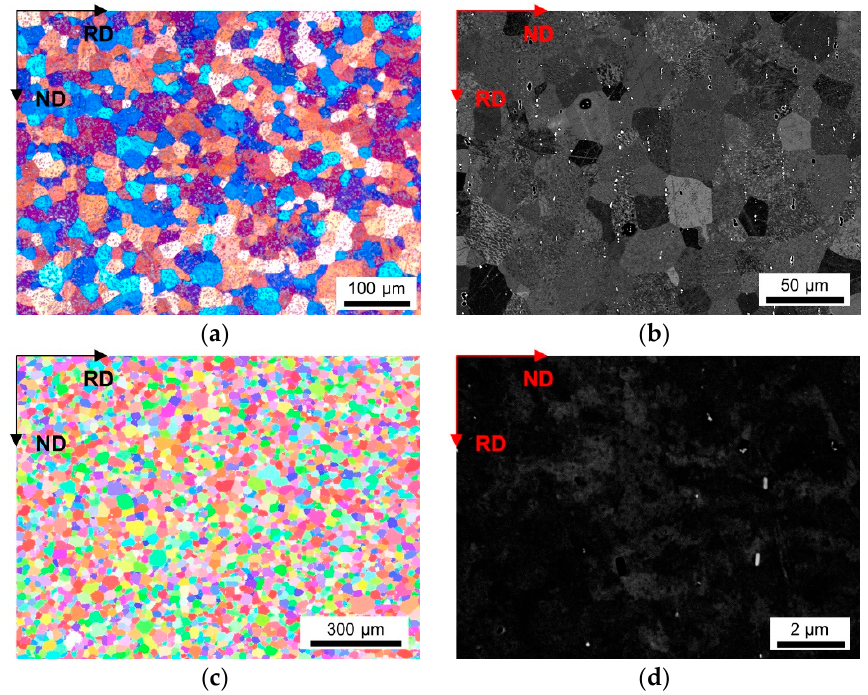
Figure A7. Microstructure of the soft annealed LFe-LMn cast under NR-C condition, homogenized at 550 °C and cold rolled to a CRD of 63%. ( a ) LOM. ( b ) BSE image. ( c ) EBSD IPF map in RD–ND plane. ( d ) BSE micrograph showing dispersoids.